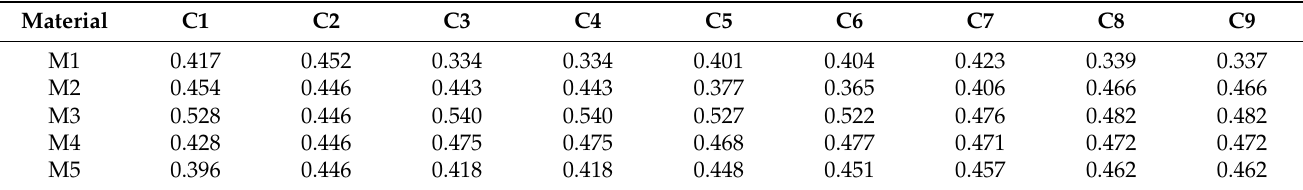
Table A5. TOPSIS normalized matrix (AHP).